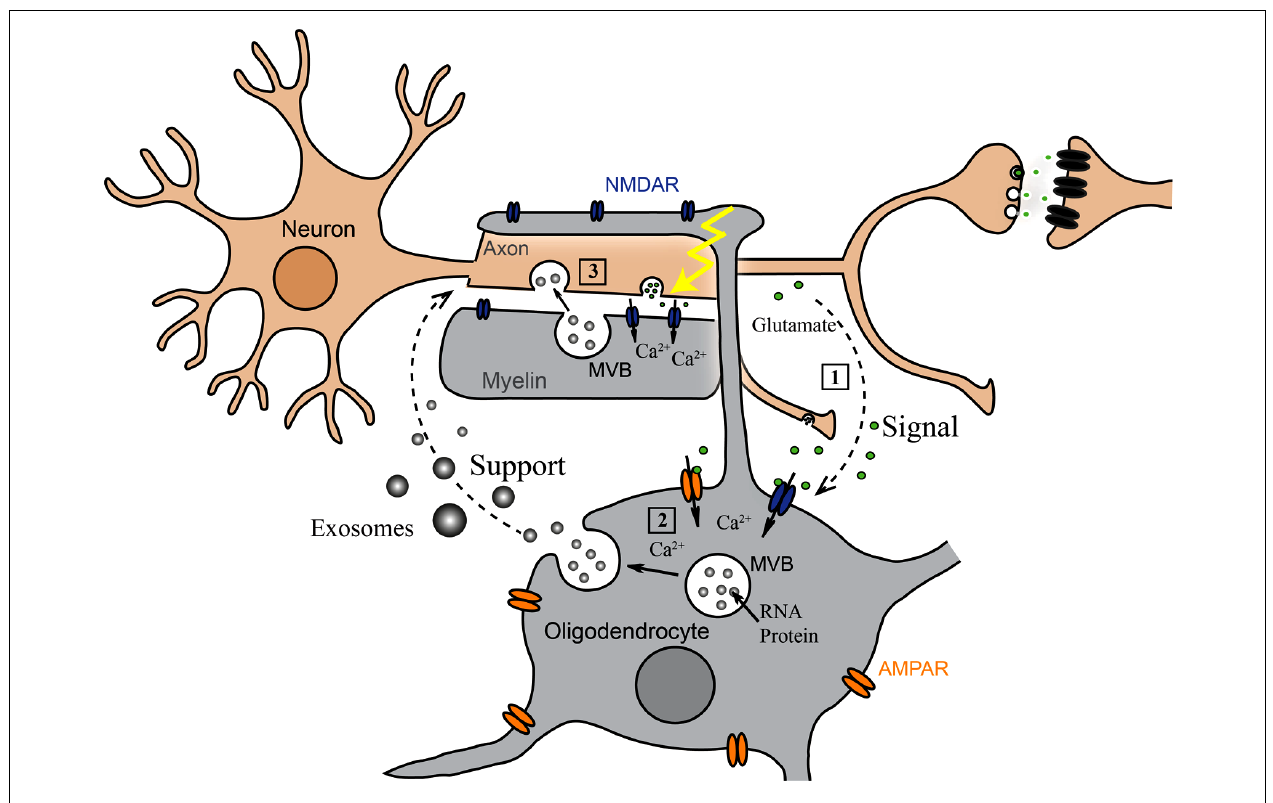
FIGURE 2 | Oligodendroglial exosomes in neuron-glia communication. (1) Electrically active axons release glutamate that provokes Ca 2 + entry through oligodendroglial glutamate receptors. (2) Elevation of intracellular Ca 2 + levels triggers exosome release from oligodendrocytes. (3) Neurons internalize exosomes and use their